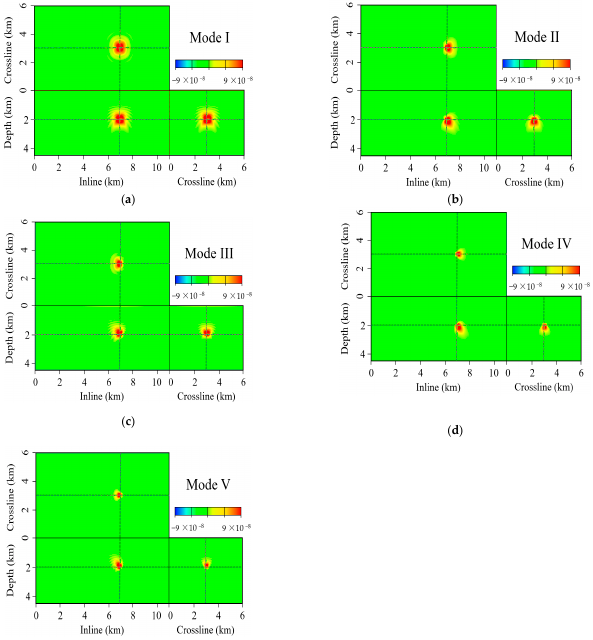
Figure 2. Snapshots of the partial derivative wavefields with different DAFs from mode I to V ( a – e ). 2.2.2. Workflow of Two-Step Monitoring with DAF The goal of 4D seismic monitoring for CCS project is finding injected CO 2 plume by estimating the changes in two sets of seismic data acquired before and after injection,